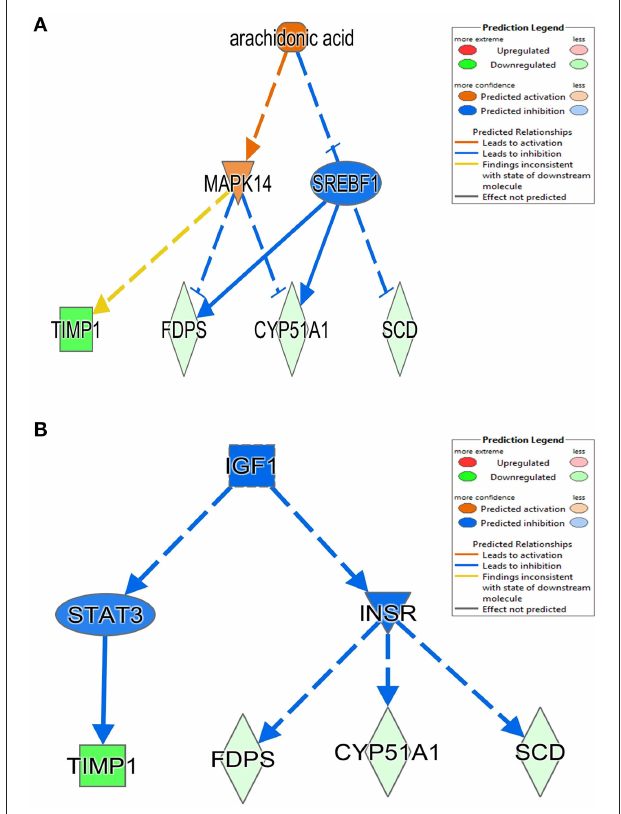
FIGURE 3 | Causal network between Phb1 + / − and WT, regulated by (A) arachidonic acid and (B) Igf1. Red, green, orange, and blue represent upregulation, downregulation, predicted upregulation, and predicted downregulation,